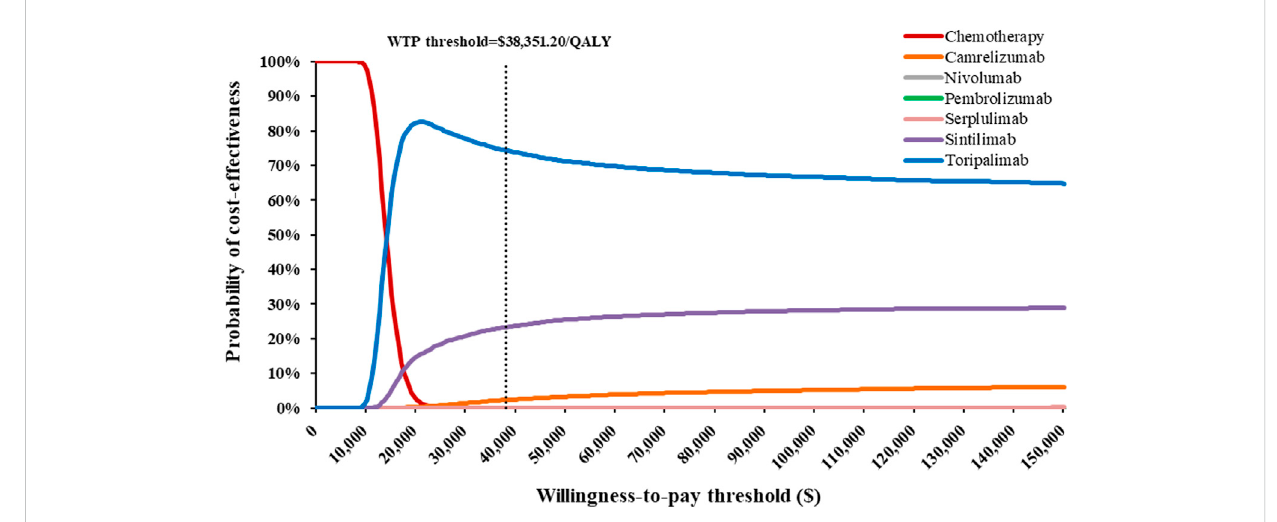
FIGURE 2 Cost-effectiveness acceptability curves indicating the probability of each treatment regimen to be cost-effectiveness in the treatment of advanced esophageal squamous-cell carcinoma at various willingness-to-pay thresholds in